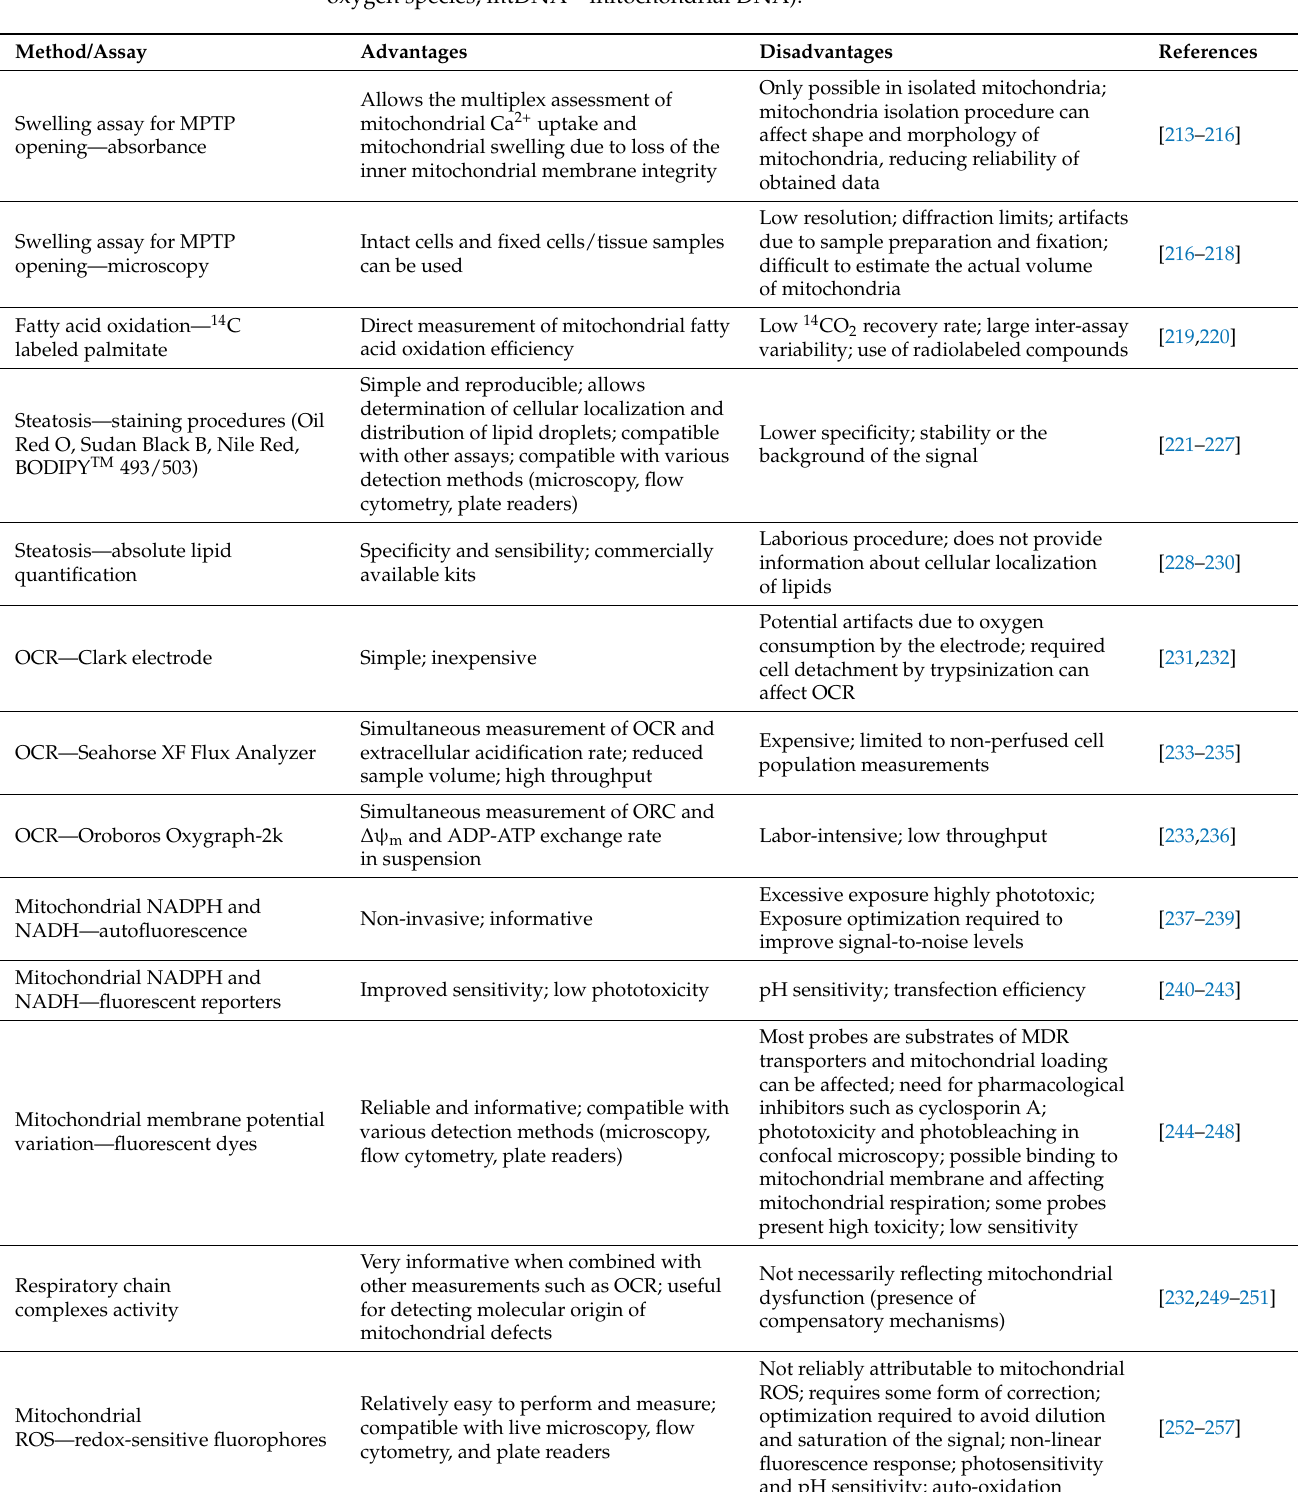
Table 4. Advantages and disadvantages of the most commonly used methods and assays for